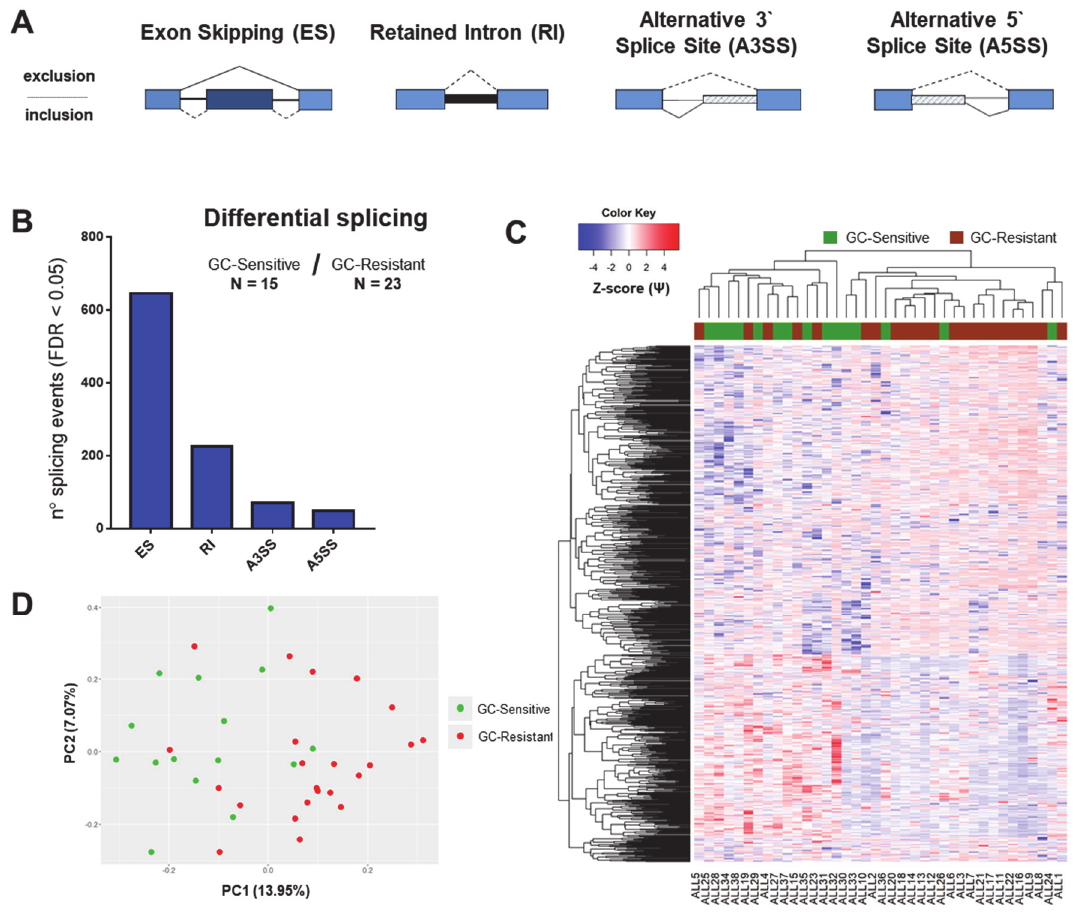
Figure 2. Global splicing profiles related to GC resistance in the total cohort of childhood ALL patients. The figure depicts the results of di ff erential splicing analysis performed on 15 GC-sensitive versus 23 GC-resistant childhood ALL samples using the rMATS algorithm. ( A ) Schematic representation of alternative splicing event types as detected by rMATS. ES: exon skipping (dark blue exon can be excluded from the mRNA transcript); RI: retained intron (thick black line represents the intron that is included in the mRNA); A3SS: alternative 3’ splice site; A5SS: alternative 5’ splice site (depending on the position of the splice site, part of introns are included in the mRNA and depicted as striped boxes). ( B ) The number of significant splicing (FDR < 0.05) events per each type. ( C ) Hierarchical clustering performed using all significant di ff erential splicing events. Inclusion levels (or Percentage Spliced-In, Ψ ) per each event were generated by rMATS, Z-score-normalized and plotted as a heatmap. The colored bar over the heatmap represents the sensitivity to GCs (green—GC-sensitive samples, brown—GC-resistant). ( D ) Principal component analysis (PCA) plot created by using Ψ values for all significant differential splicing events.